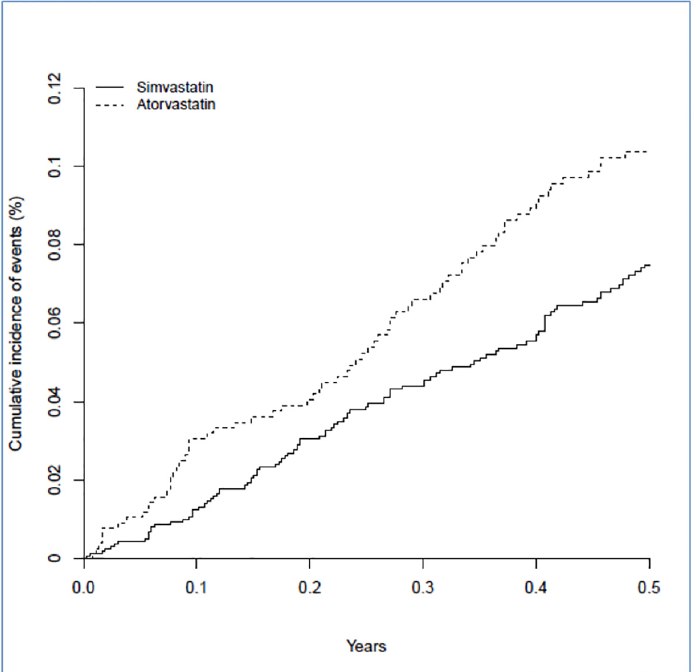
Fig 1. Cumulative incidence of moderate-severe hepatotoxicity for atorvastatin and simvastatin [all doses] over 6 months after index dose.